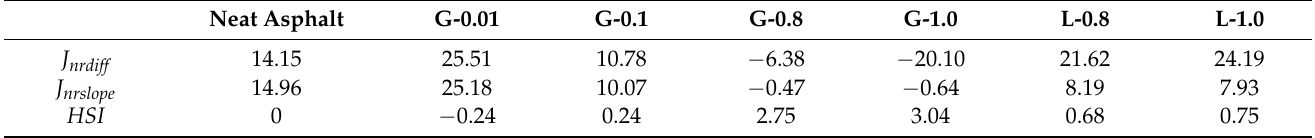
Table 5. J nrdiff , J nrslope and high temperature stiffening index of different